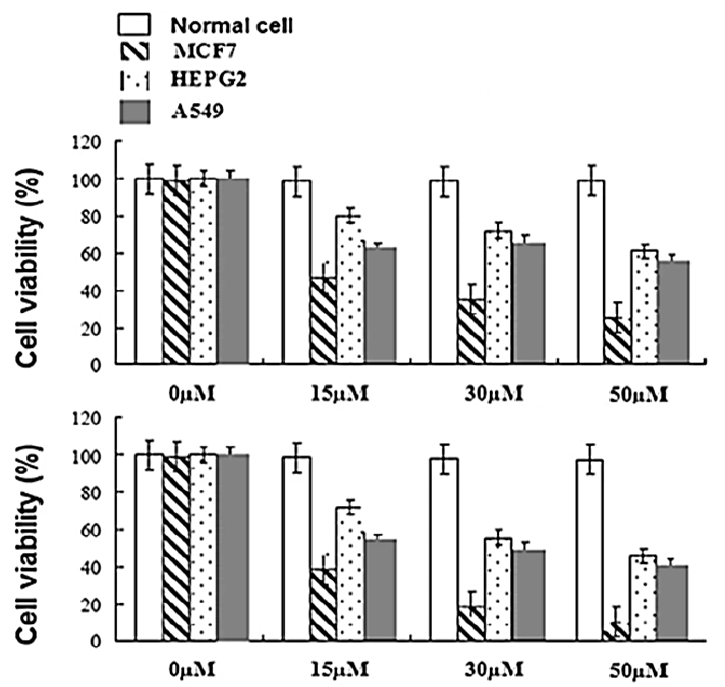
Figure 14. Cell viability for compound 59 ( top ) and compound 60 ( bottom ). Cells analyzed by MTT assay and treated with different concentrations (15, 30, and 50 µM) of dyes 59 and 60 . Figure used assay and treated with different concentrations (15, 30, and 50 µ M) of dyes 59 and 60 . Figure used with permission from [53]. Copyright 2018 Springer Nature. with permission from [53]. Copyright 2018 Springer Nature.